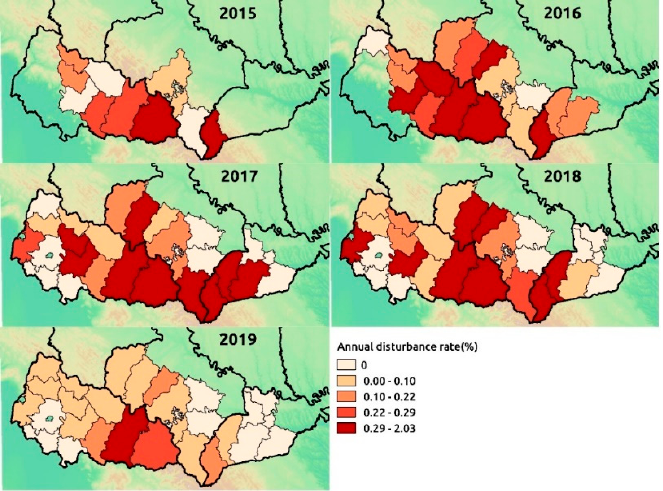
Figure 7. Distribution of Old-Growth Forest (OGF) annual disturbance for 2015–2019 calculated for raions (districts) and Iaremchans’ka Municipality (mis’ka rada).